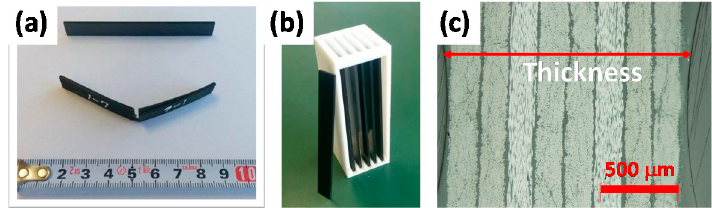
Figure 2. CFRP samples ( a ) CFRP test pieces for bending strength; ( b ) CFRP samples for sealed stemless autoclave; ( c ) cross-section image of CFRP.